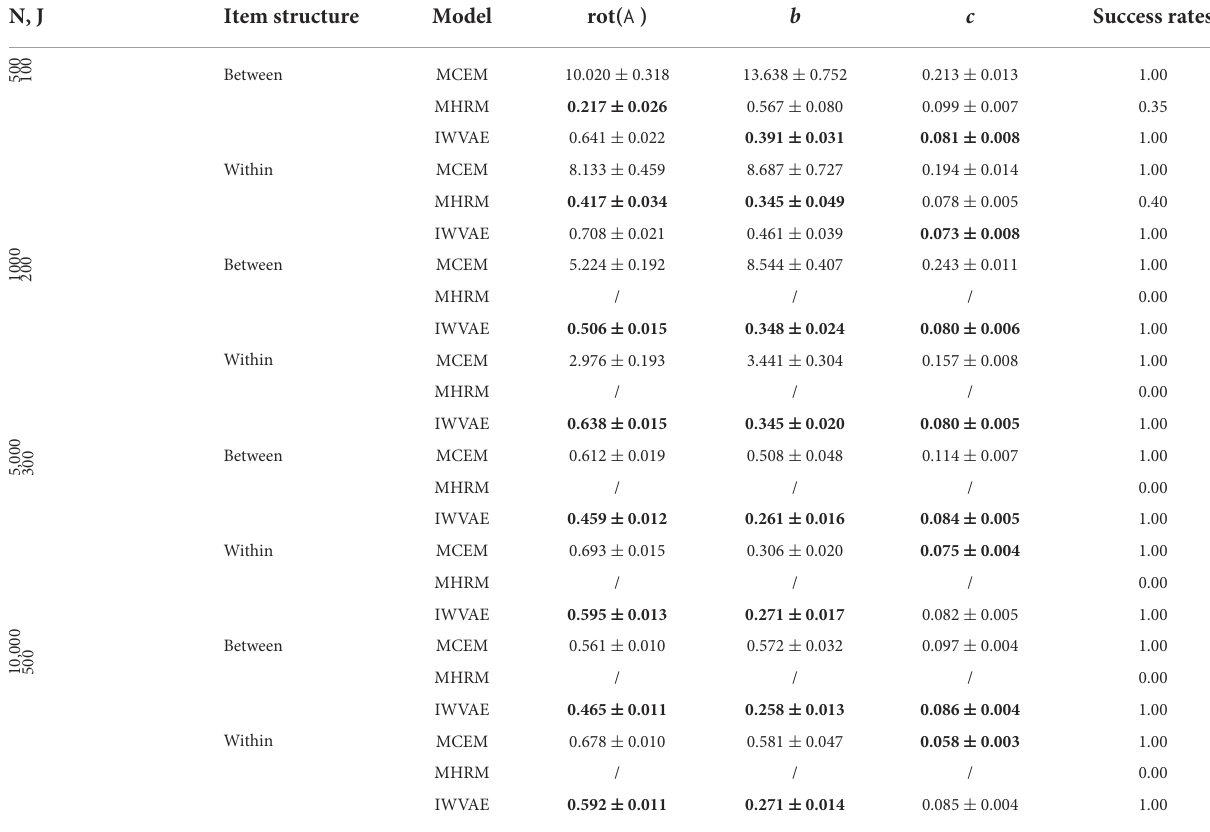
TABLE 4 Mean and SE of RMSE of M p estimate on M3PL models under double regime setting, best results are in bold. N, J Item structure Model c Success